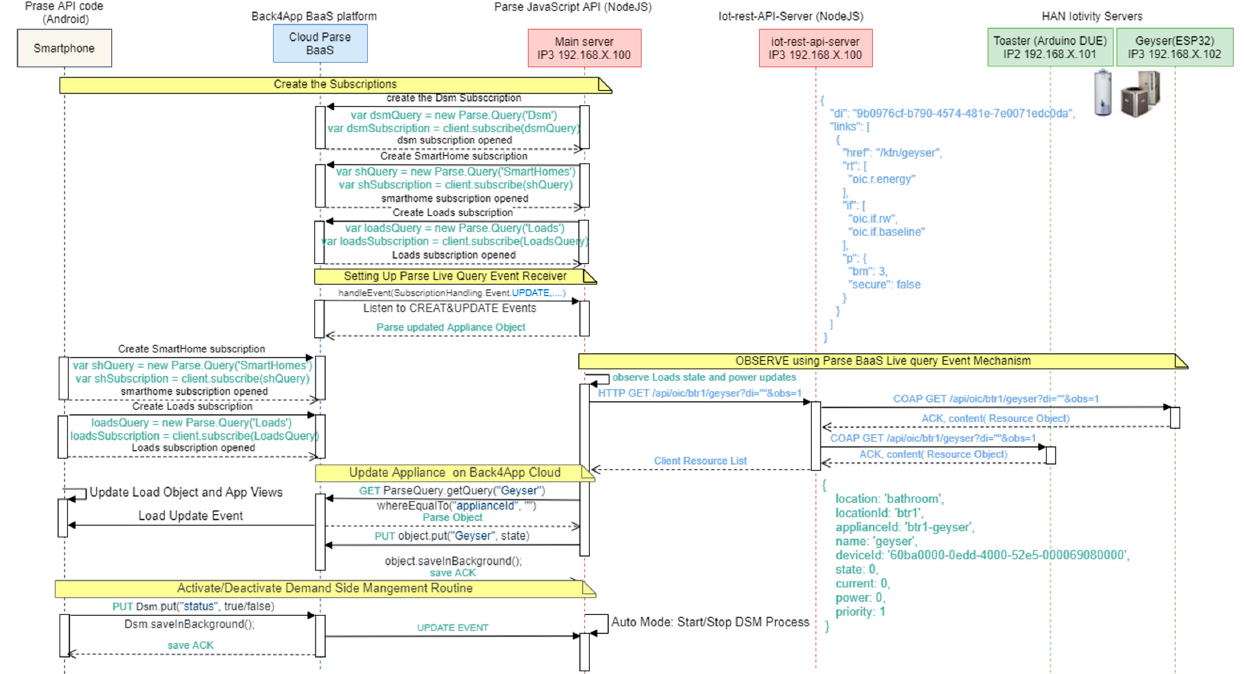
Figure 5. Communication flow with remote/local Android smartphone app.